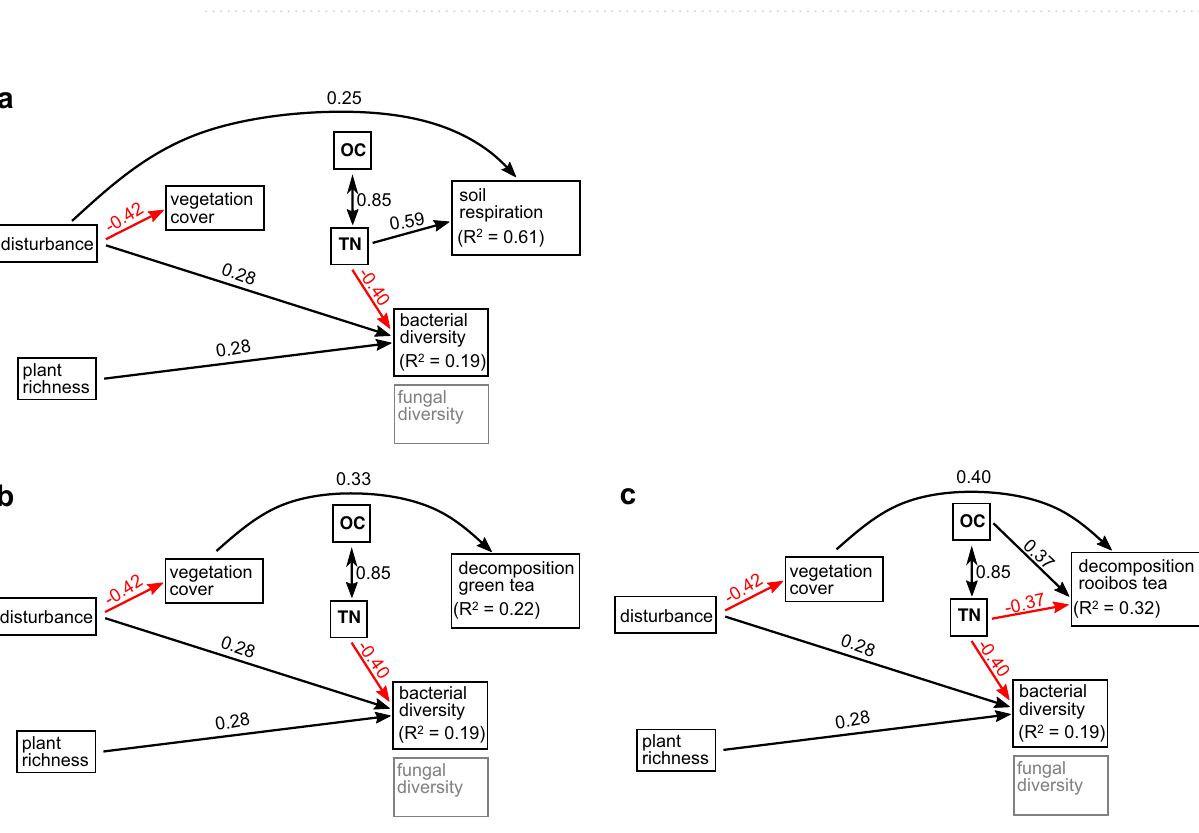
Figure 6. Structural equation models for the sampling year 2016. Subfigures show results for different soil functions as terminal response variable: soil respiration ( a ), decomposition of green tea ( b ), decomposition of rooibos tea ( c ). Arrows show direction of significant effects at p < 0.05, line color indicates sign of relationship (black: positive, red: negative). Double-headed arrows indicate bi-directional correlation. Standardized coefficients are given as numbers next to the arrows. Marginal R 2 -values of soil functions are given for microbial diversity and soil functions. Variables with no significant pathway are shaded in